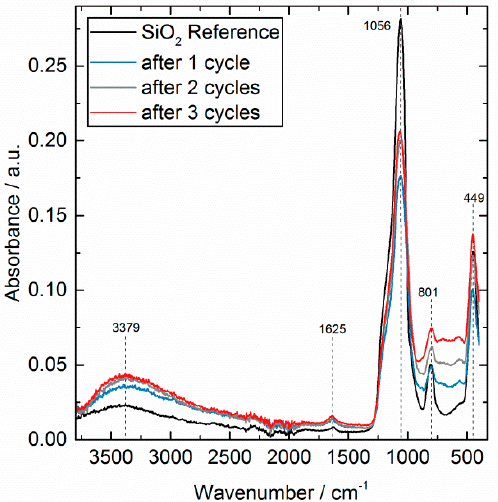
Figure 5. Absolute ATR-FTIR spectra of the SiO 2 reference (black) and the AlO x deposited samples after 1 cycle (blue), 2 cycles (grey), and three cycles (red) at 200 °C using TMA and H 2 O. Atmospheric background is subtracted.